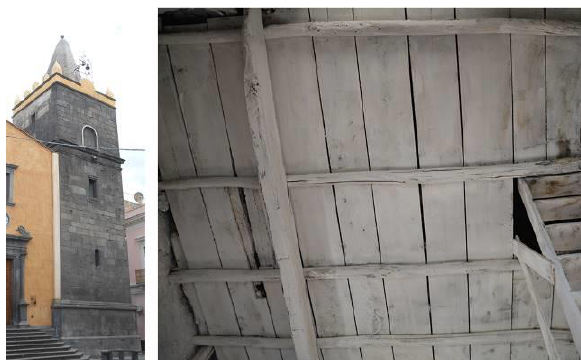
Figure 4. The bell tower of San Giovanni in Bronte (Ct). On the right, the floor under the cusp.